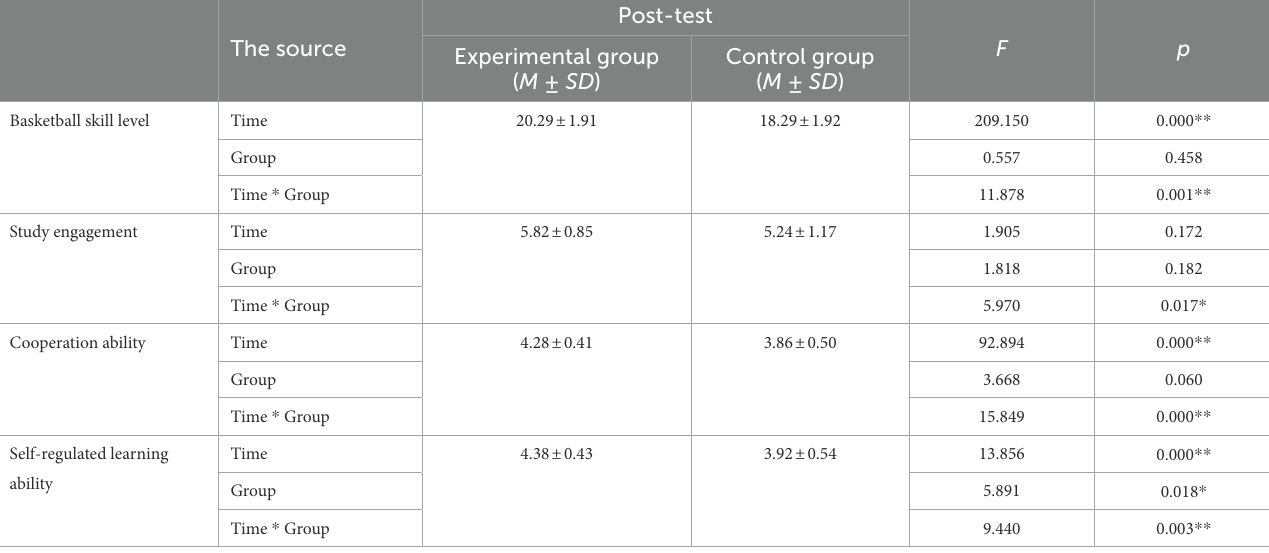
TABLE 2 Repeated measures ANOVA results of experimental group and control group.